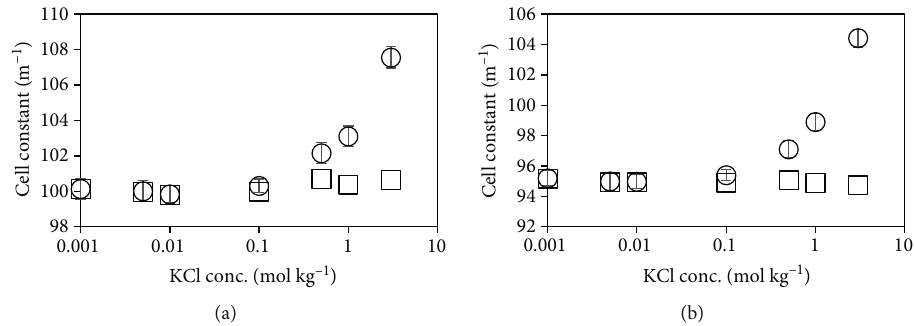
Figure 5: The cell constants of (a) ECM-1 and (b) ECM-2 obtained by calibration using the seven KCl standard solutions. Open circles are calculated by measured solution resistance and open squares are calculated by measured resistance subtracted cable resistance. The calculated cable resistances were 0.25 Ω (ECM-1) and 0.37 Ω (ECM-2). The bars were expanded uncertainties ( k = 2 ) which were estimated by the combination of the following uncertainties: resistances of the LCR meter (0.025%), thermometer (0.008%), measurement repeatability (less than 0.1%), and the cell constant of NMIJ secondary Jones-type cell (0.28%). Table 2: The resistances measured obtained by linear extrapolation for two EC meters commercially